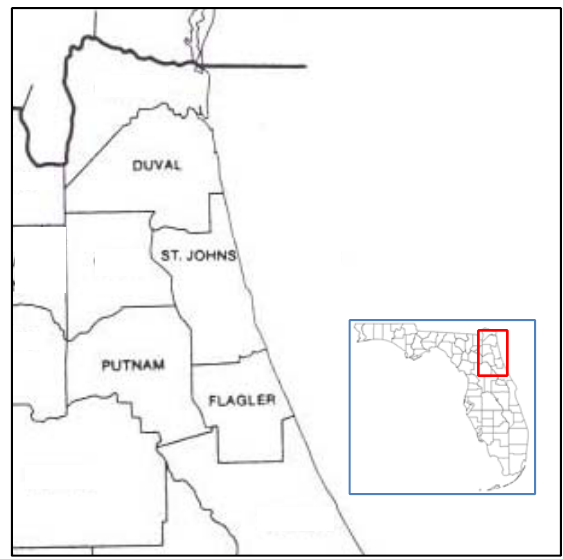
Figure 1. Case Study Area Consisting of Duval,